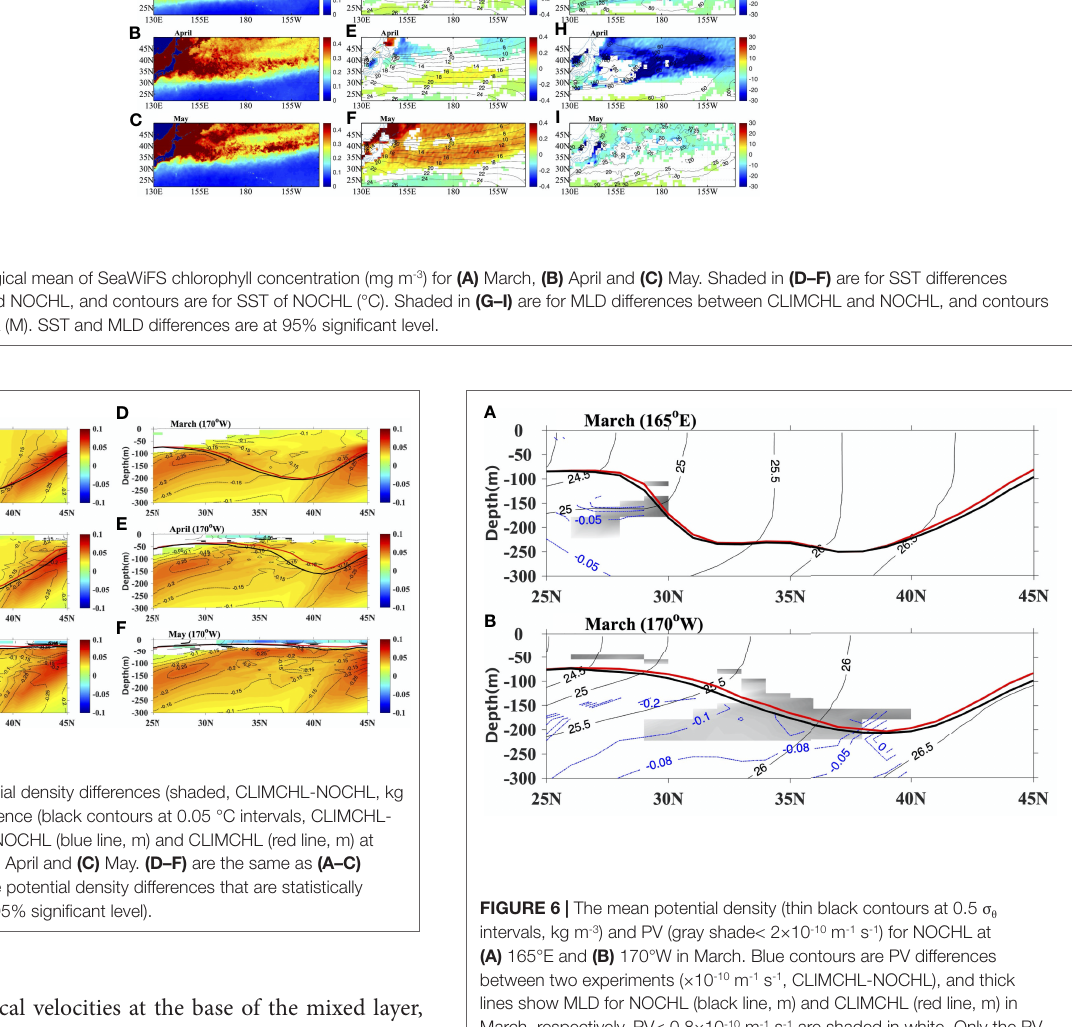
FIGURE 6 | The mean potential density (thin black contours at 0.5 σ intervals, kg m -3 ) and PV (gray shade< 2×10 -10 m -1 s -1 ) for NOCHL at (A) 165°E and (B) 170°W in March. Blue contours are PV differences between two experiments (×10 -10 m -1 s -1 , CLIMCHL-NOCHL), and thick lines show MLD for NOCHL (black line, m) and CLIMCHL (red line, m) in March, respectively. PV< 0.8×10 -10 m -1 s -1 are shaded in white. Only the PV differences that are statistically significant are shown (95% significant